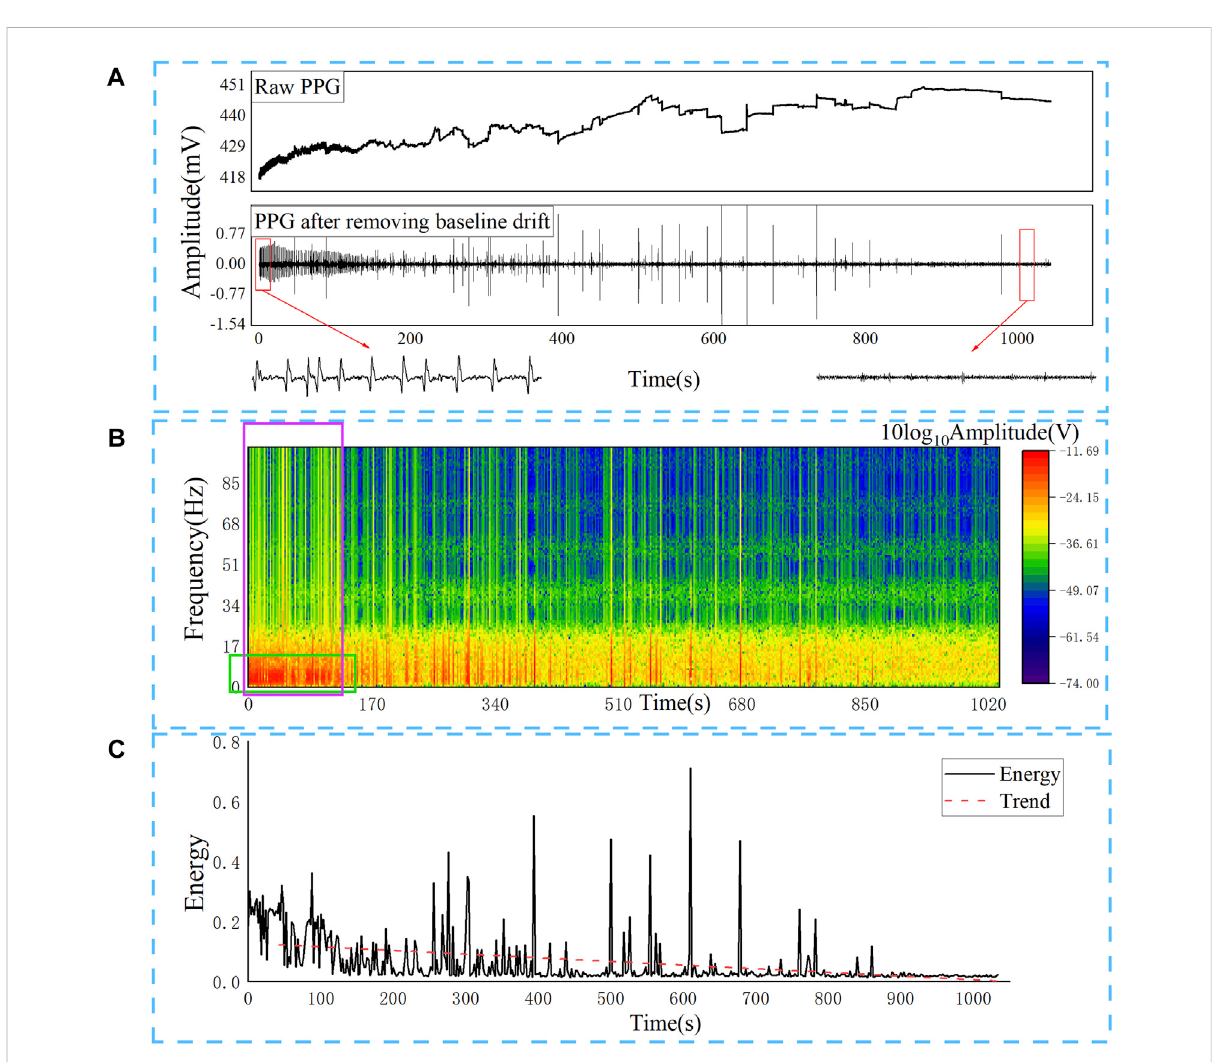
FIGURE 4 After removing the baseline drift of the original red light PPG, it can be seen that the pulsation gradually disappears, and low-frequency components in the frequency domain are gradually decreasing, and the total energy is continuously decreasing. (A) Red light PPG after band-pass fi ltering and wavelet processing; (B) Time-frequency change of red light PPG; (C) Energy change of red light